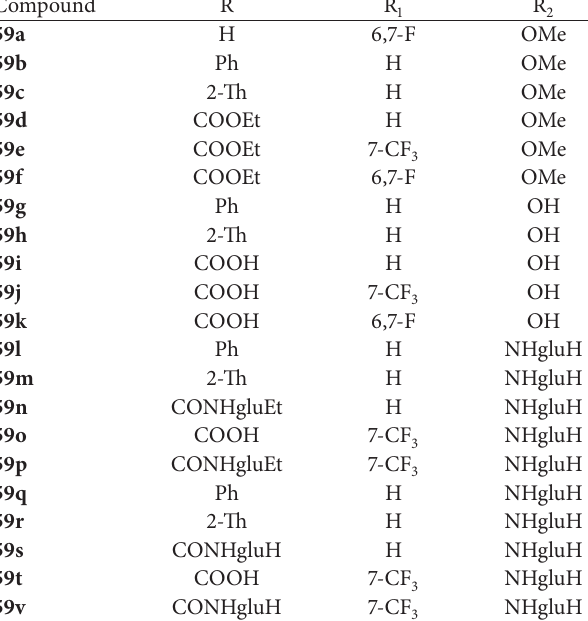
Table 9: List of compounds prepared.